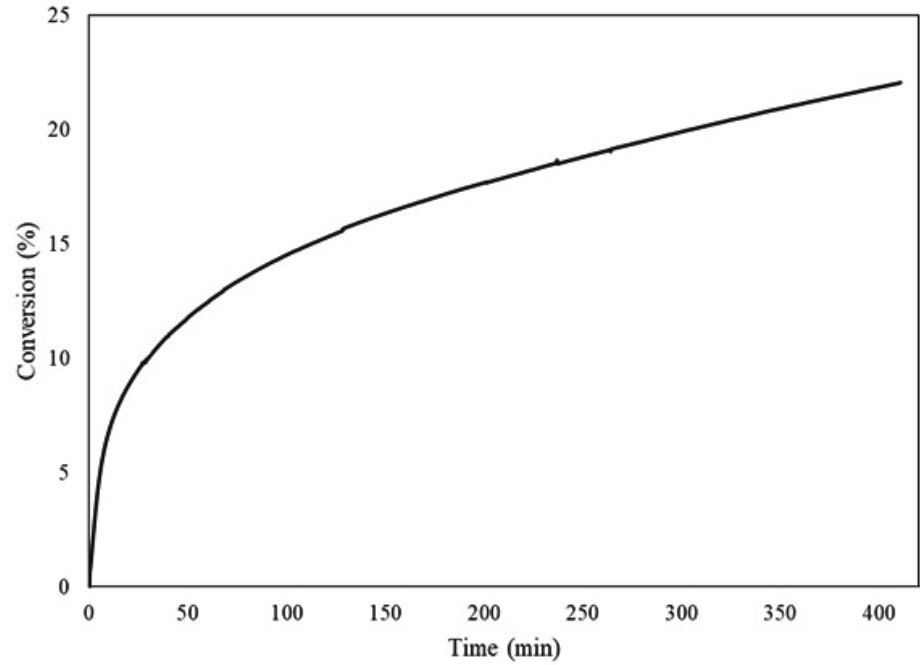
Fig. 8 – Average overall MgSO conversion in the packed bed reactor system as the function of reaction time 4 Table 4 – Summary of the comparison between MgO rate constant with other sorbents